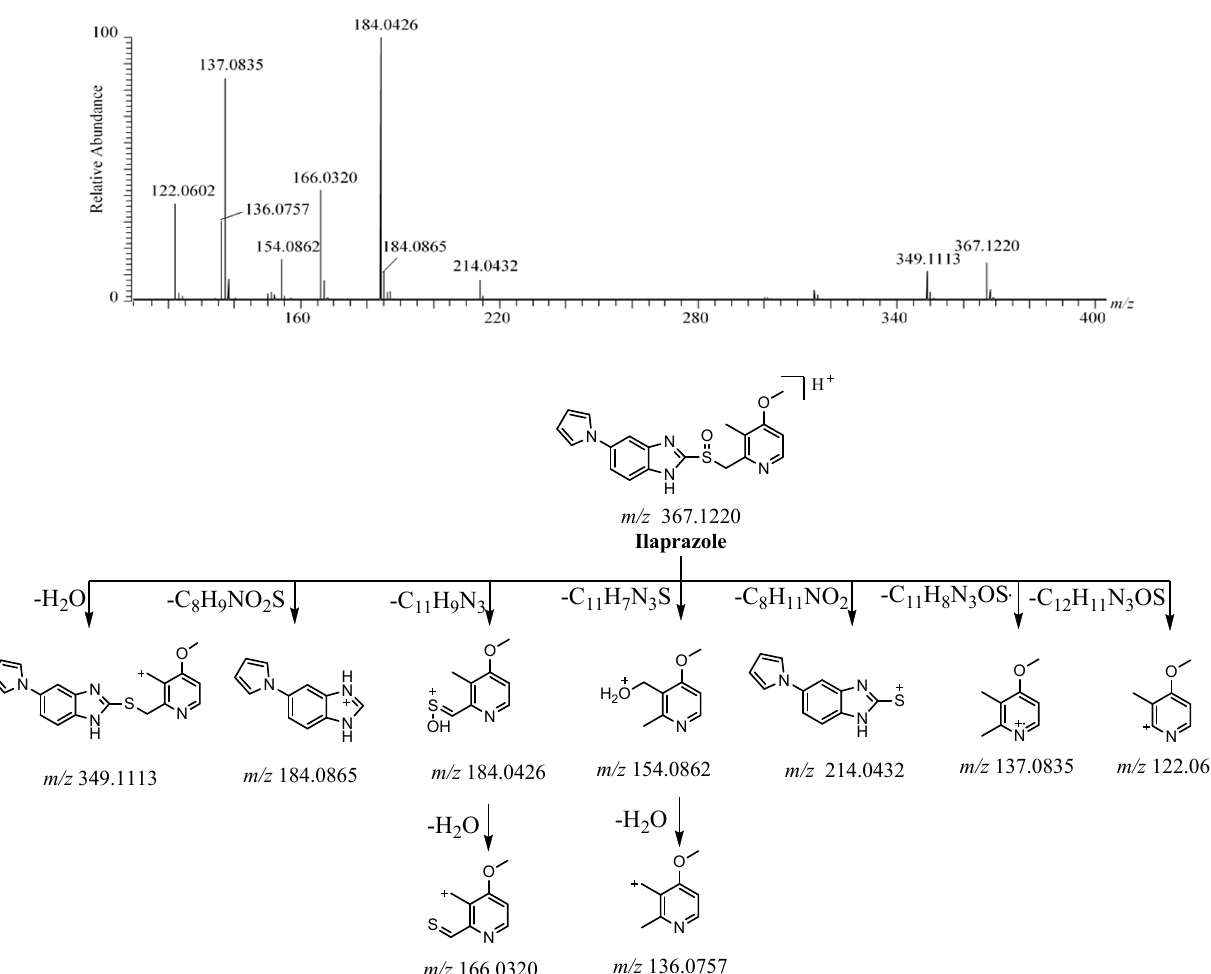
Figure 3. The tandem high-resolution mass spectrometry (HRMS/MS) spectrum and the possible fragmentation pathway of ilaprazole.